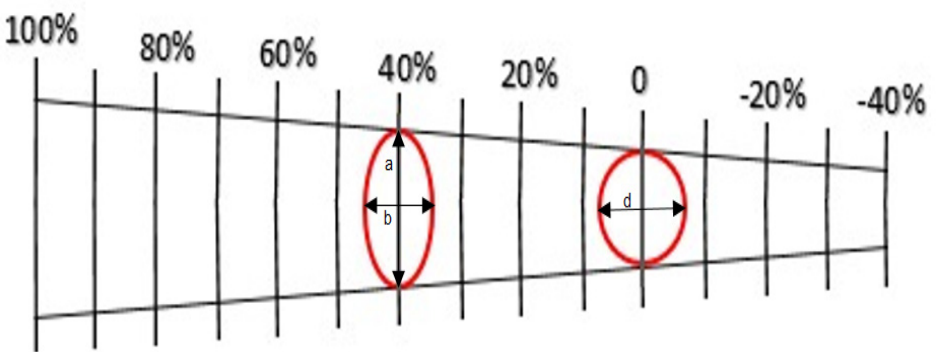
Figure 3. Mylar tape, showing the diameters of d, a, and b.